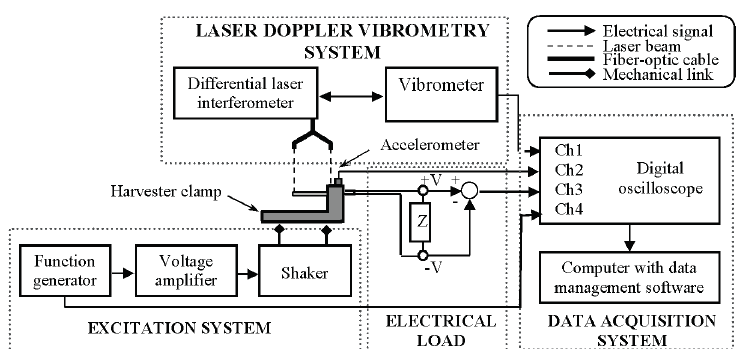
Figure 4. Scheme of the laser Doppler vibrometry system.